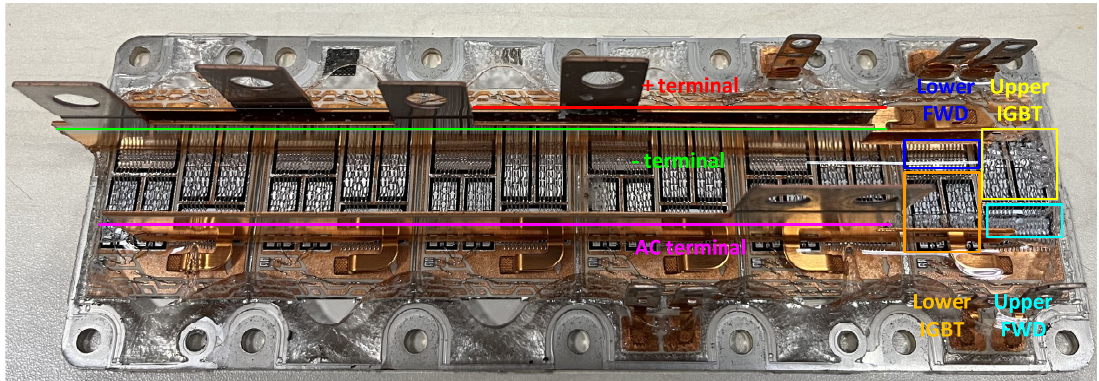
Figure 11. The chips layout and power terminal structure of PrimePACK3.